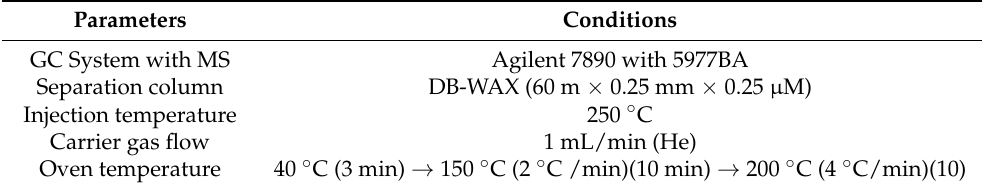
Table 2. Operational conditions for gas chromatography-mass spectrometer (GS/MS) analysis to quantify volatile compounds.